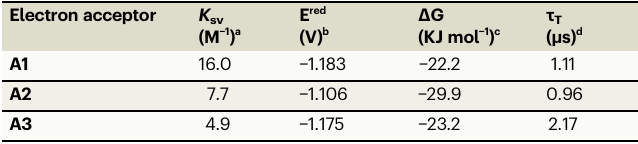
Table 1 | The relevant data on photoinduced electron transfer between D and A Electron